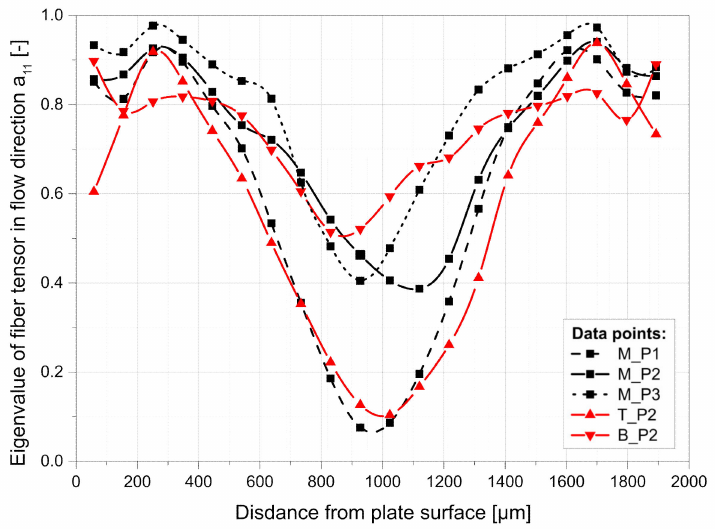
Figure 6. Eigenvalues of fiber orientation tensor over plate thickness at the evaluated